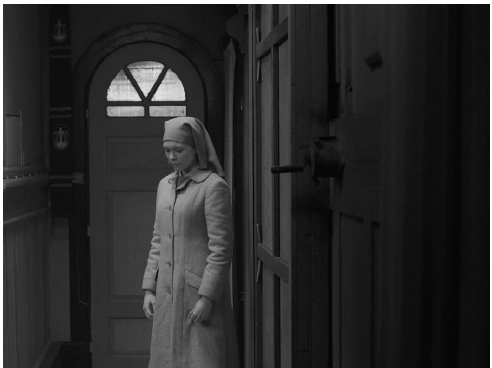
Figure 14. Early in a scene with balanced framing.